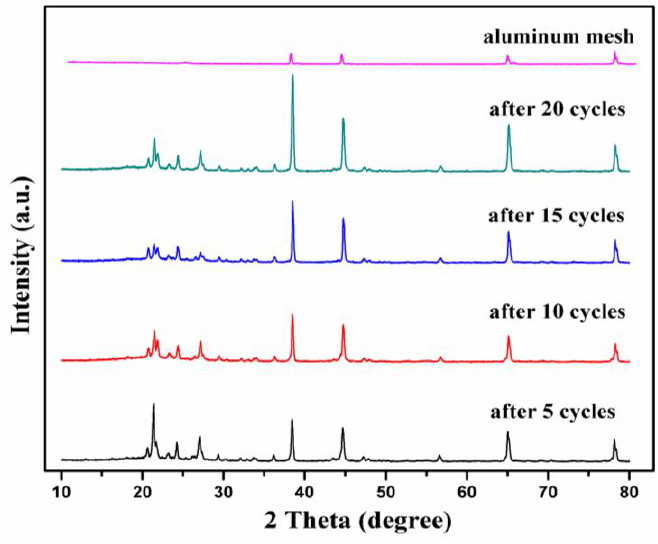
Figure 8. Ex-situ XRD patterns of LVPBC-0.14 electrode under fully discharged state at the different cycles.